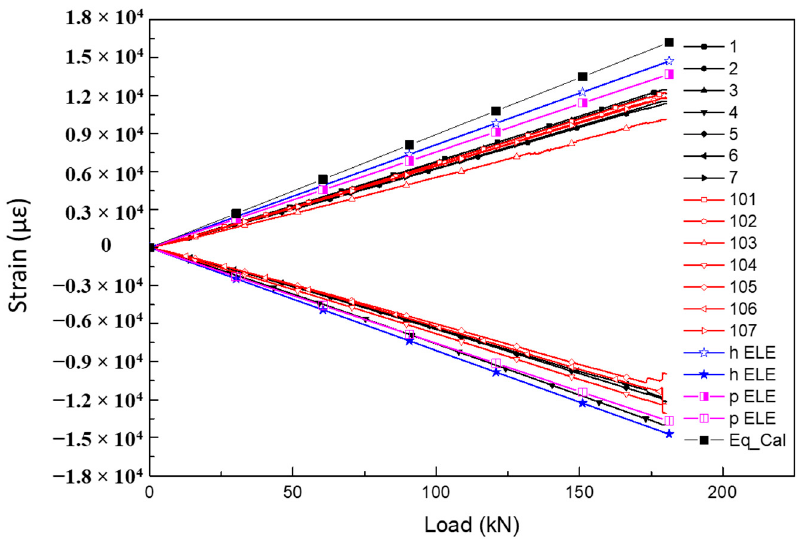
Figure 17. Comparison of strain vs. load curves at positions of strain gauge obtained from prediction and experimental.